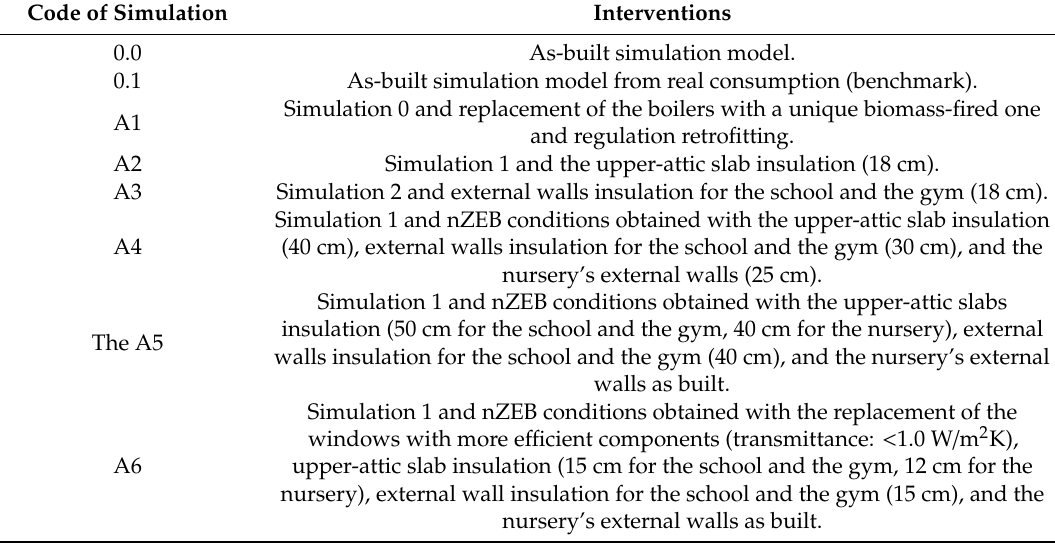
Table 7. Retrofit alternatives for Oulx pilot case study. nZEB: nearly Zero Energy Building. Code of